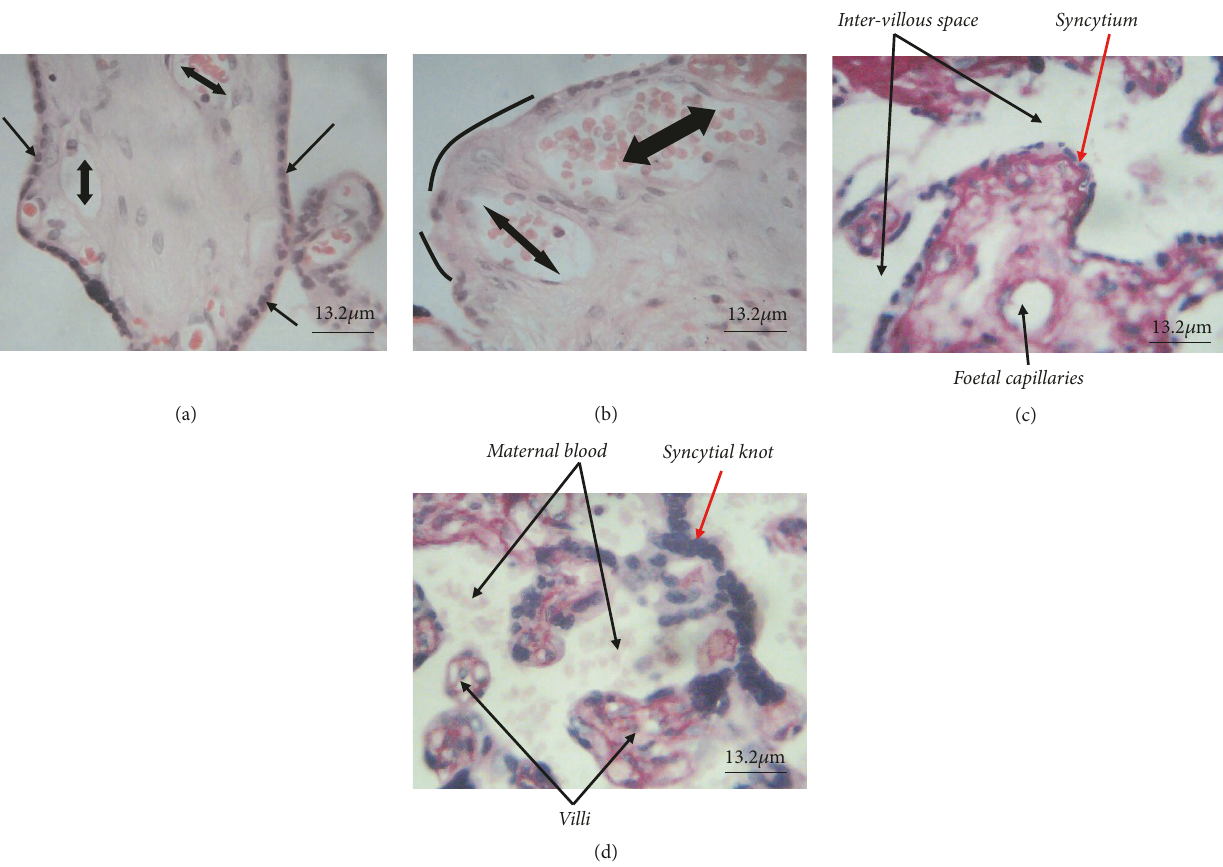
Figure 3: Histomorphological assessment of placental tissues (H&E stained). (a) Placental tissue of control sample with normal syncytium indicated with single head arrow . (b) Placental tissue of case sample with syncytial necrotic areas indicated with curvy lines . Double head arrows in (a) and (b) indicate foetal capillaries. (c) and (d) show internal architecture of the placenta tissues in control and study groups, respectively; notable among them is the normal syncytium in (c) compared to the significant number of syncytial knots seen in (d), indicated by red